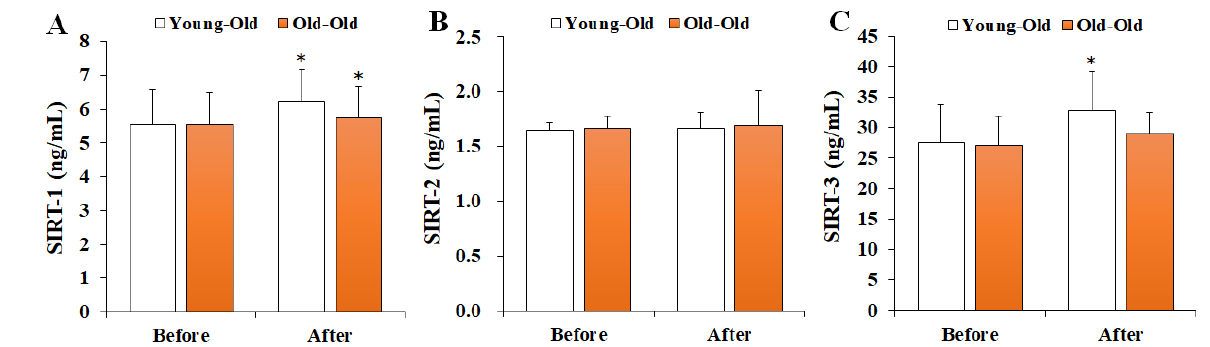
Figure 4. Changes in serum SIRTs levels. Values presented by mean and standard deviation. ( A ) SIRT-1, sirtuin-1; ( B ) SIRT-2, sirtuin-2; ( C ) SIRT-3, sirtuin-3; * Significantly different versus Before ( p < 0.05).